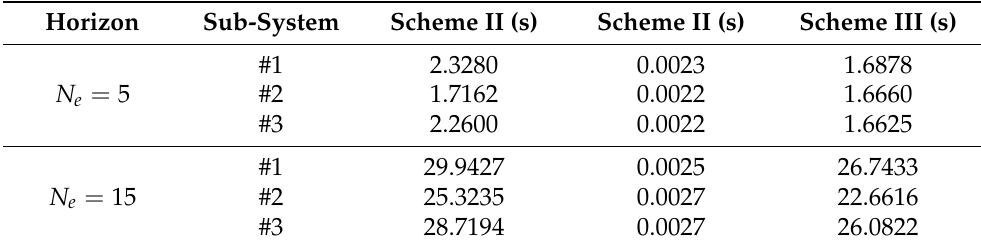
Table 3. Comparison of mean evaluation time of different schemes for each